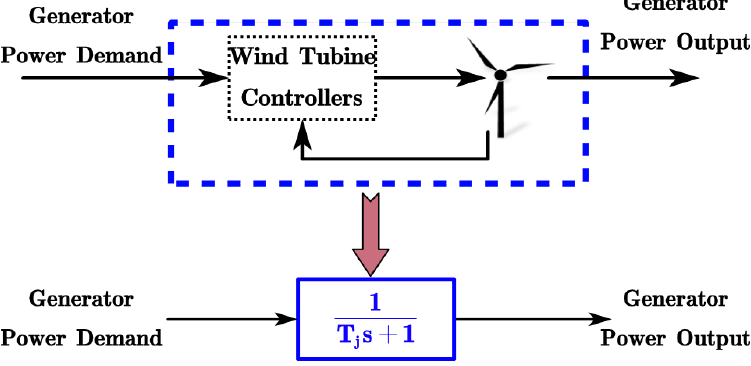
Figure 2. Wind turbine power tracking dynamic